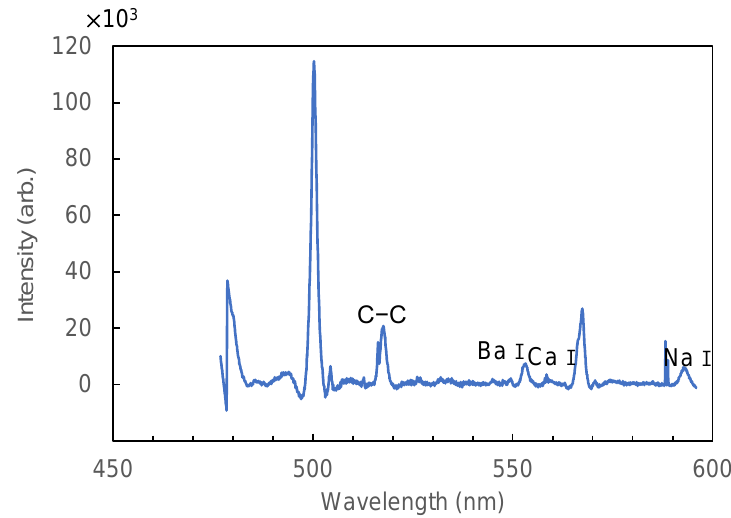
Figure 6. LIBS spectrum of hair measured in the visible wavelength region.